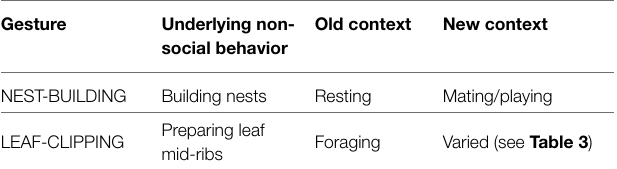
TABLE 4 | Group-specific gestures potentially based on non-social